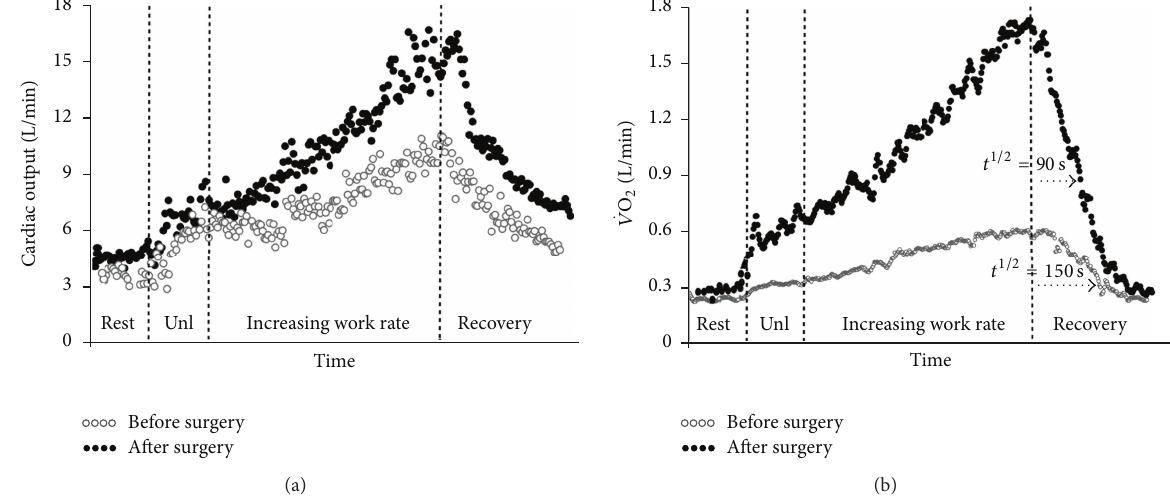
Figure 6: Incremental cycle ergometer exercise tests in the same patient of Figure 4 with chronic thromboembolic pulmonary hypertension. After pulmonary endarterectomy ( closed symbols ), haemodynamic improvement ( panel (a)) led to a higher oxygen uptake ( exerciseandafaster(lowerhalf-time (𝑡 1/2 ) post-exercisedecreasein cardiography and the tests were time-aligned by total exercise duration. Unl is unloaded